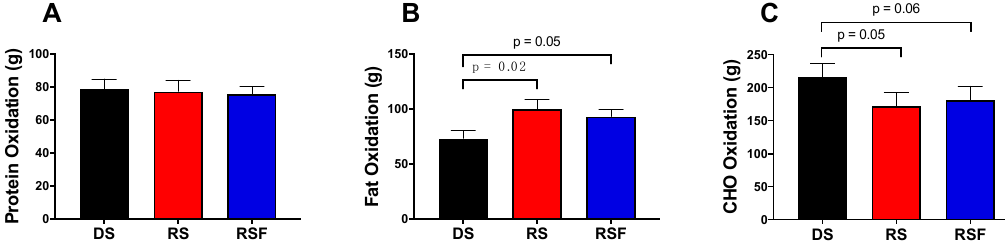
Figure 2. Macronutrient Oxidation. Oxidation of ( a ) Protein, ( b ) Fat, and ( c ) Carbohydrate (CHO) following consumption of digestible starch (DS), resistant starch (RS), or resistant starch with high fiber (RSF), as measured by whole-room indirect calorimetry. Data are expressed mean ± SEM.